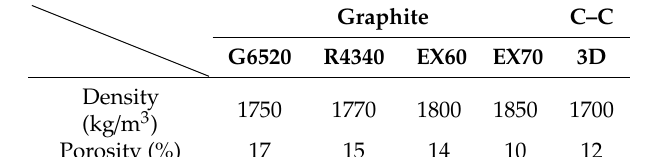
Table 2. Density and porosity of the graphite and C–C composite.